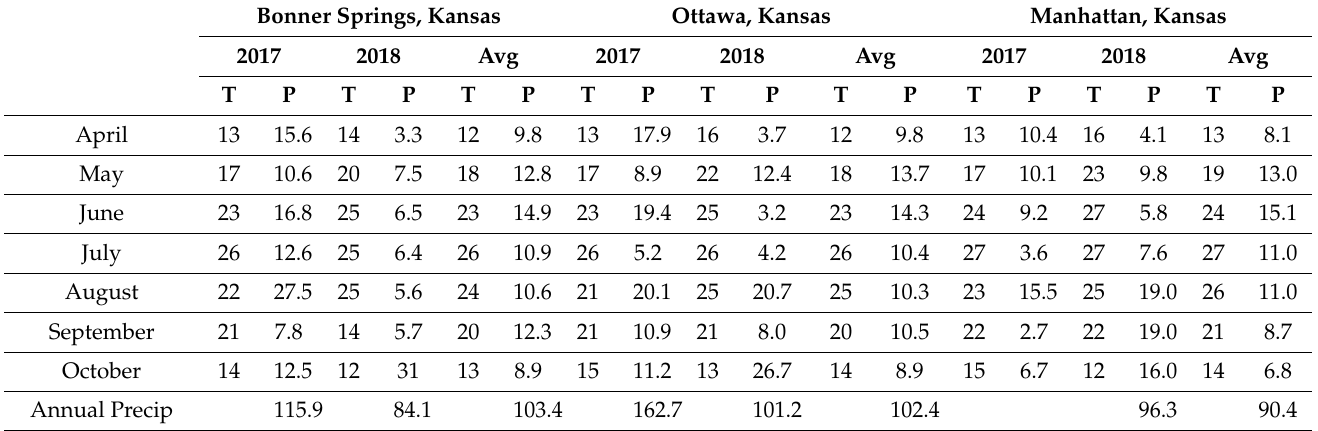
Table 1. Monthly temperature and precipitation values for 2017 and 2018, at measurement sites nearest to collection sites. Bonner Springs is nearest to the two north Johnson County sites. Ottawa is used for the south Johnson County site, and Manhattan is the location for the Riley County sites. Temperatures (T) are mean monthly values in ◦ C. Precipitation (P) is monthly totals in cm. Average values are included for comparison, and are for the entire period of record at each station. Data source: NOAA National Climate Data Center